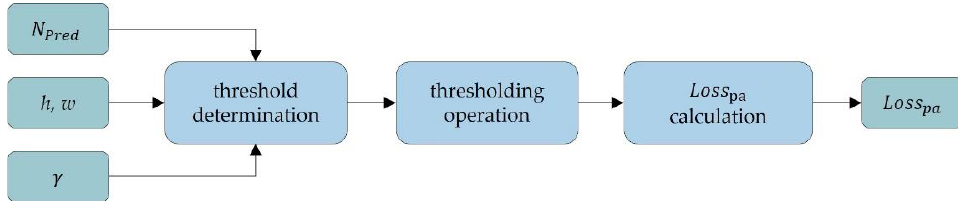
Figure 9. Structure of penalty area loss computation.